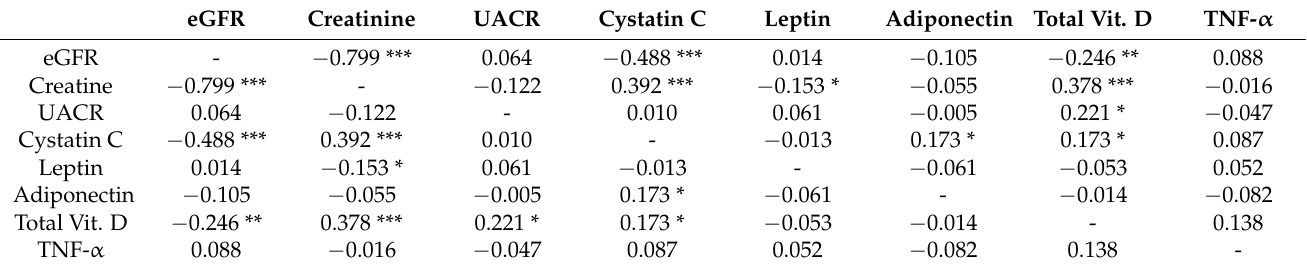
Table 2. Correlation between eGFR, UACR, and the serum levels of biomarkers at baseline (Pearson correlation coefficients: r).